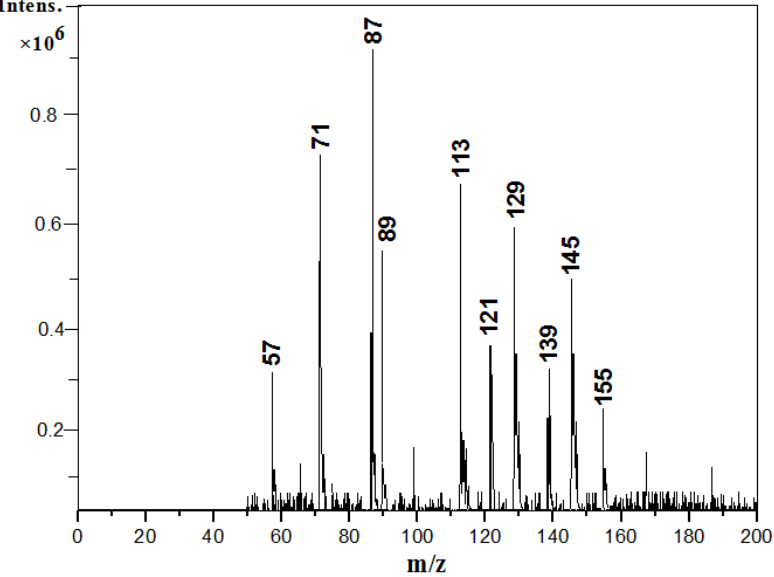
Figure 7. Negative mass spectrum of SOA without (NH 4 ) 2 SO 4 seed.